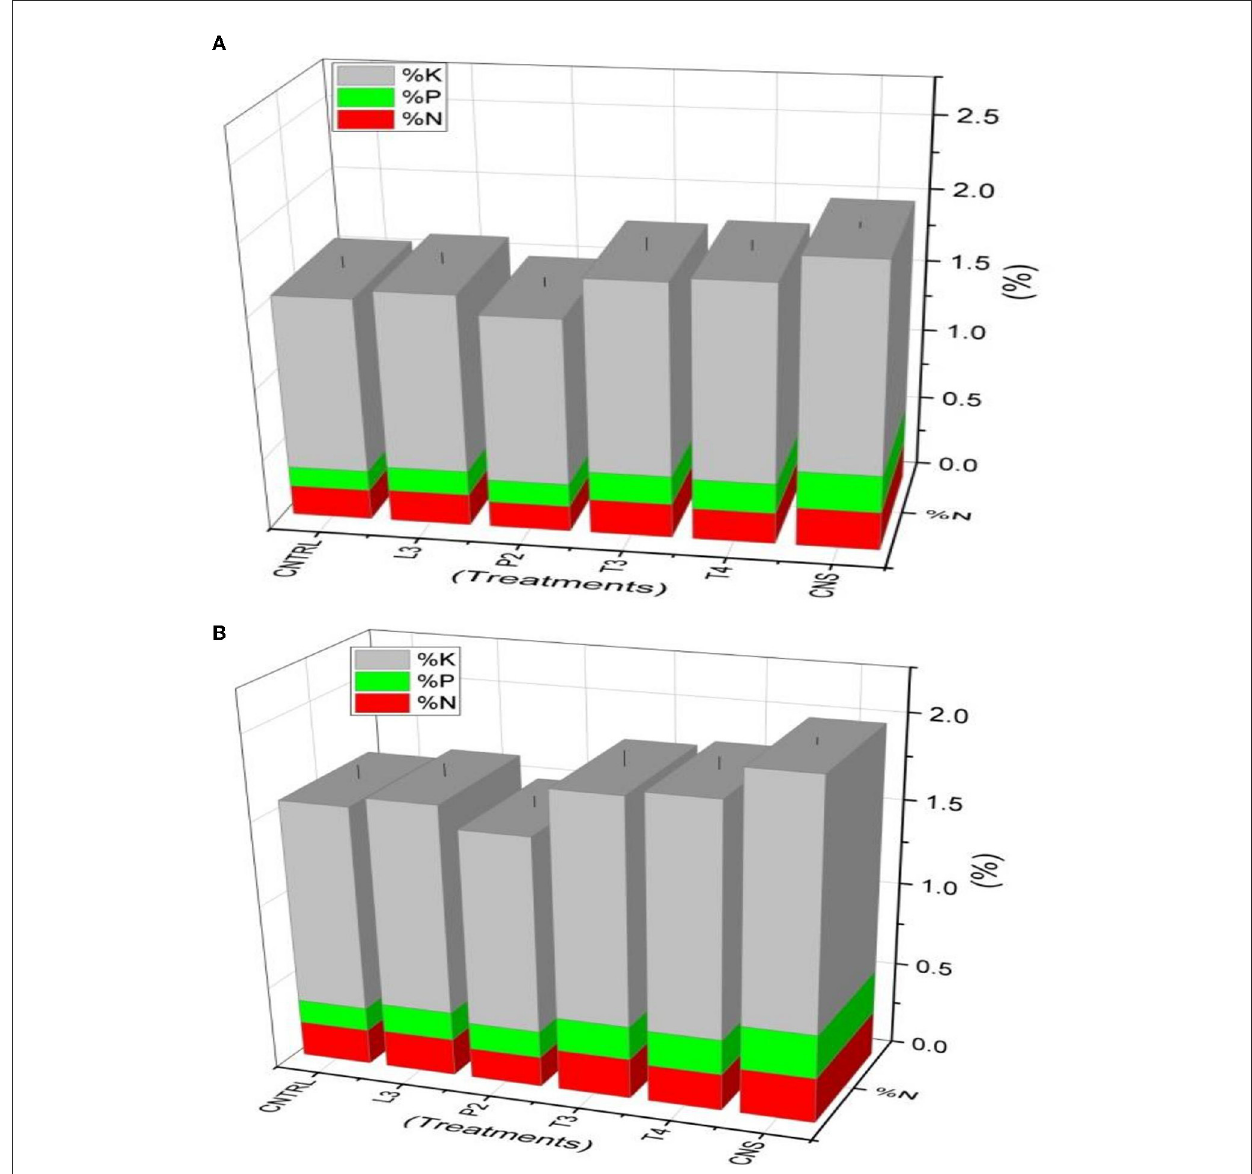
FIGURE9 Nutrient analysis (N, P, and K) in plant sample (A) field set 1 (PSB + RDF), (B) field set 2 (PSB –